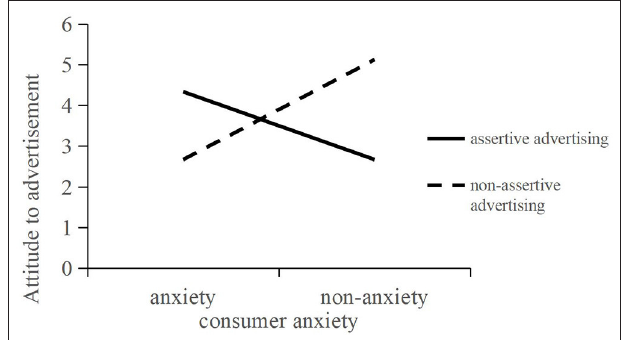
FIGURE 3 | The interaction between advertising types and consumer anxiety in Experiment